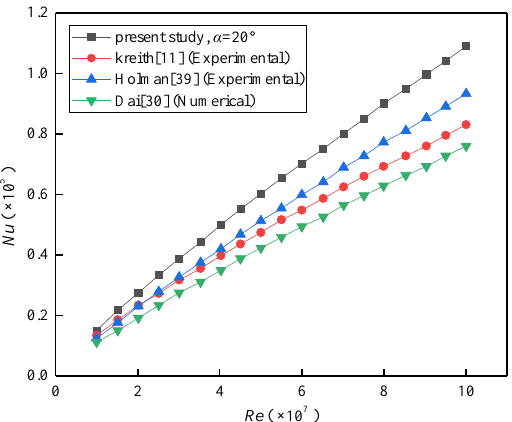
Figure 9. Comparison of values of the Nusselt number from the present study with α = 20 ° , with those from the literatures.